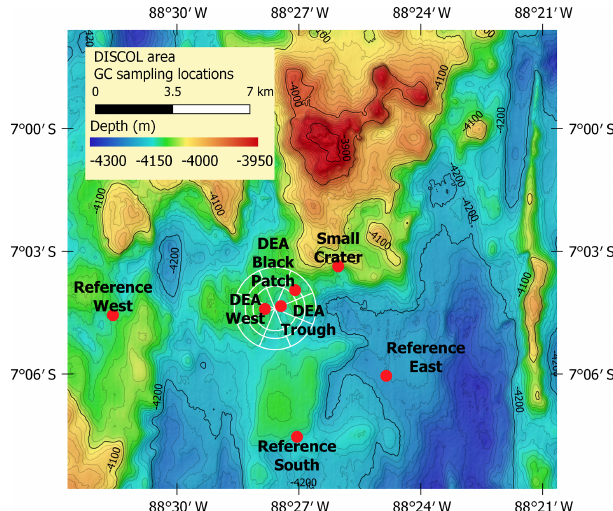
Figure 2. GC sampling locations in the Peru Basin. The circle indi- cates the DISCOL experimental area (DEA) that was traversed with a plow harrow. Created with QGIS with bathymetry data provided by Anne Hennke and Jens Greinert, DSM group,